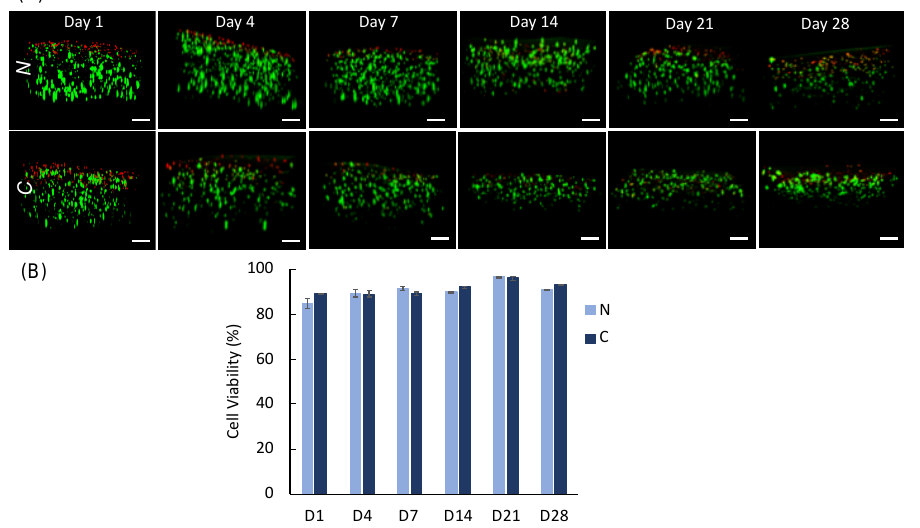
Figure 9. Cell viability studies. ( A ) Confocal images of hMSCs showing cross-sectional views of neat (top) and composite (bottom) scaffolds. Green and red cells indicate live and dead cells, respectively. Scale bars are 200 µm. ( B ) Plot showing percent cell viability with culture day for hMSCs within bioprinted neat ( N ) and composite ( C ) scaffolds. Data are presented as mean ± std. deviation for n = 3 samples with 3 measurements for each sample.